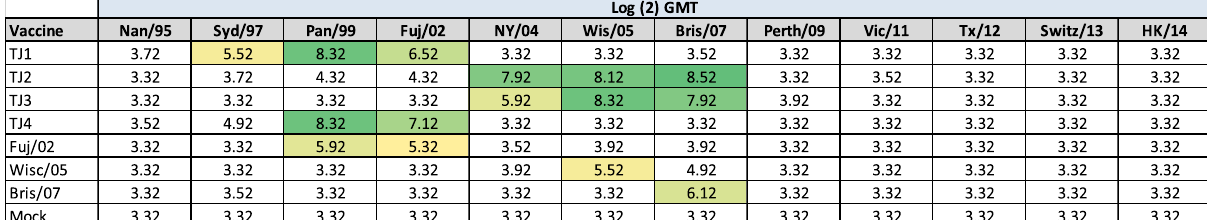
Table 1. Historical influenza virus HAI panel. HAI assays were performed against a panel of historical influenza virus vaccine strains isolated from 1995 – 2016 with day 70 serum from vaccinated mice. The average log